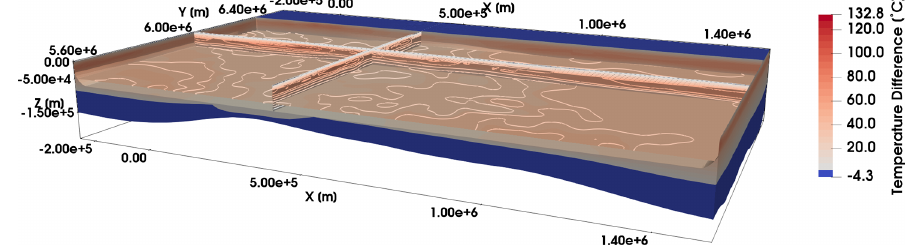
Figure 14. Difference in the temperature distribution between the state at 10.0Ma and 583.9ka for the transient simulation considering a simulation time of 255.7Myr.